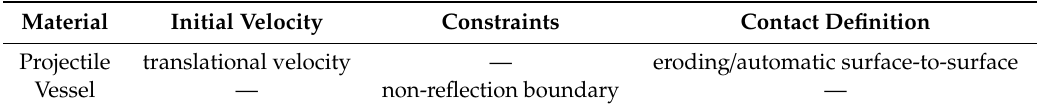
Table 3. Boundary conditions of the simulation model.